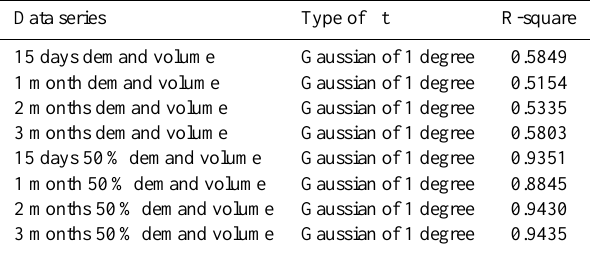
Table 2. Types of fit and goodness of fit for each density probability function of the number of days of closed urban supply